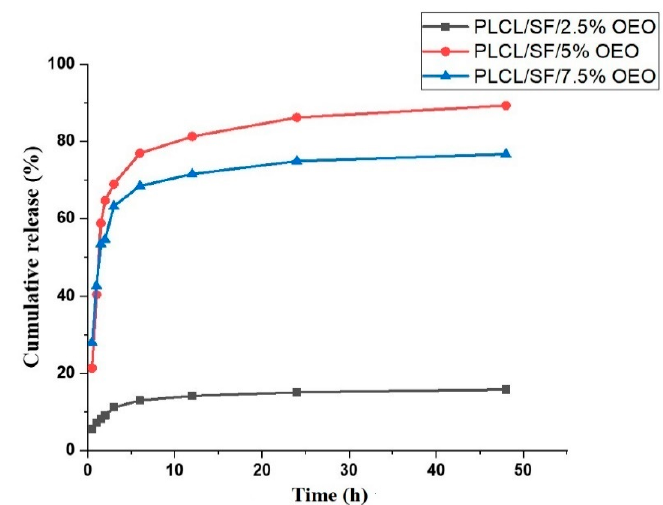
Figure 5. Cumulative release (%) of OEO from PLCL / SF / 2.5% OEO, PLCL / SF / 5% OEO and PLCL / SF / 7.5% OEO.